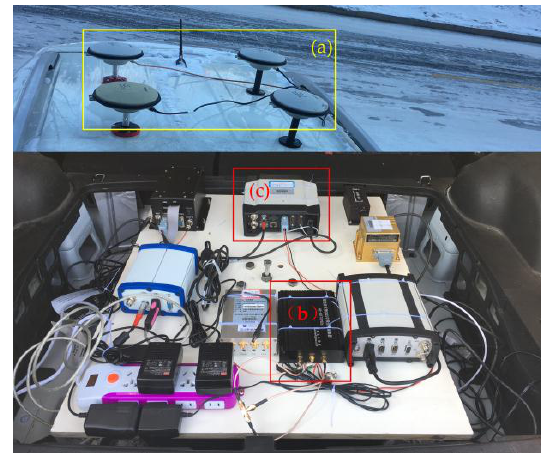
Figure 14. GNSS comprehensive test platform, ( a ) stand for GNSS antennas, ( b ) is the intermediate frequency signal sampler, and ( c ) is ProPak6 receiver.